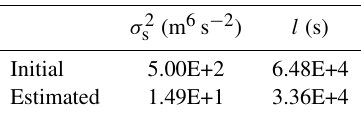
Figure 15. December 2009 recorded stage hydrographs on the Sec- chia River at sections B and C. Table 6. Secchia 2009 event: initial and estimated structural param- eters.